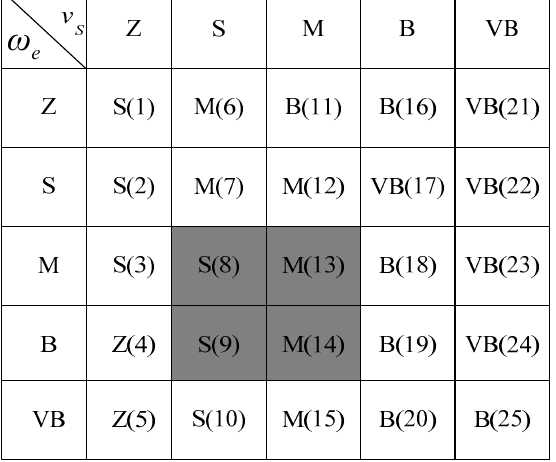
Figure 7. MTPV rule table.